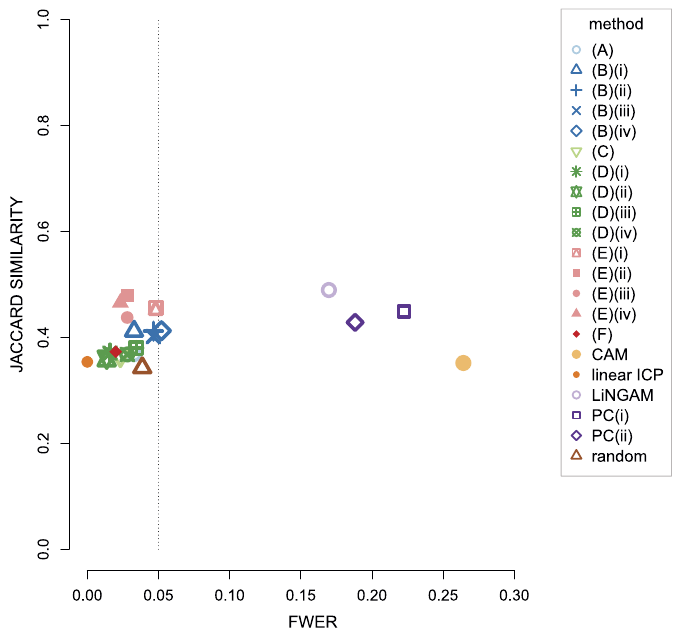
Figure 7: Average Jaccard similarity ( y -axis) against average FWER ( x -axis), stratified according to which conditional